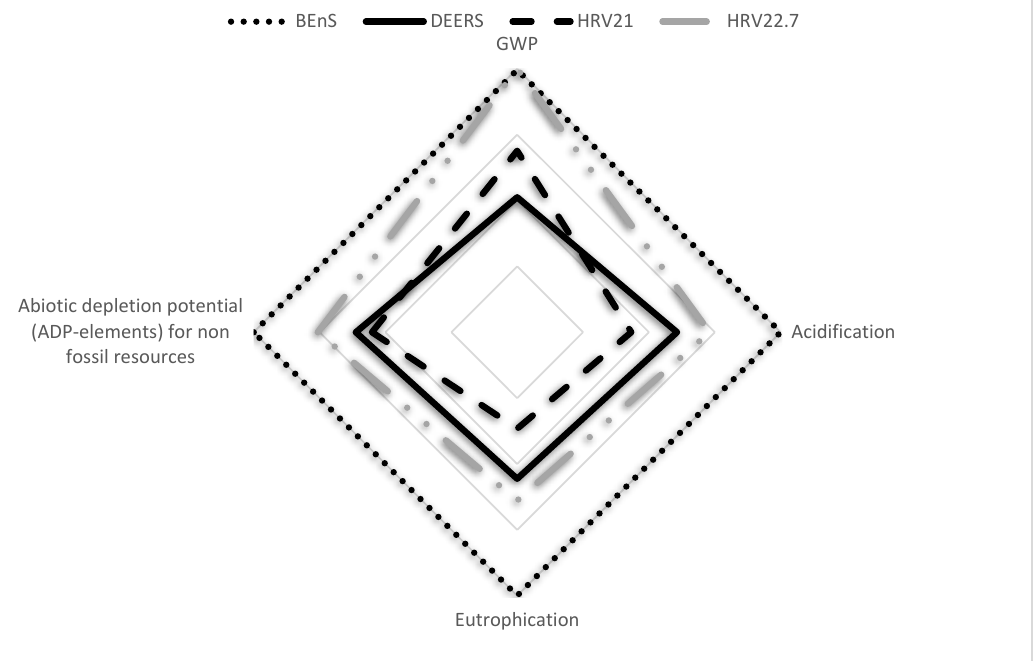
Figure 6. Life cycle assessment (LCA) results in percent.